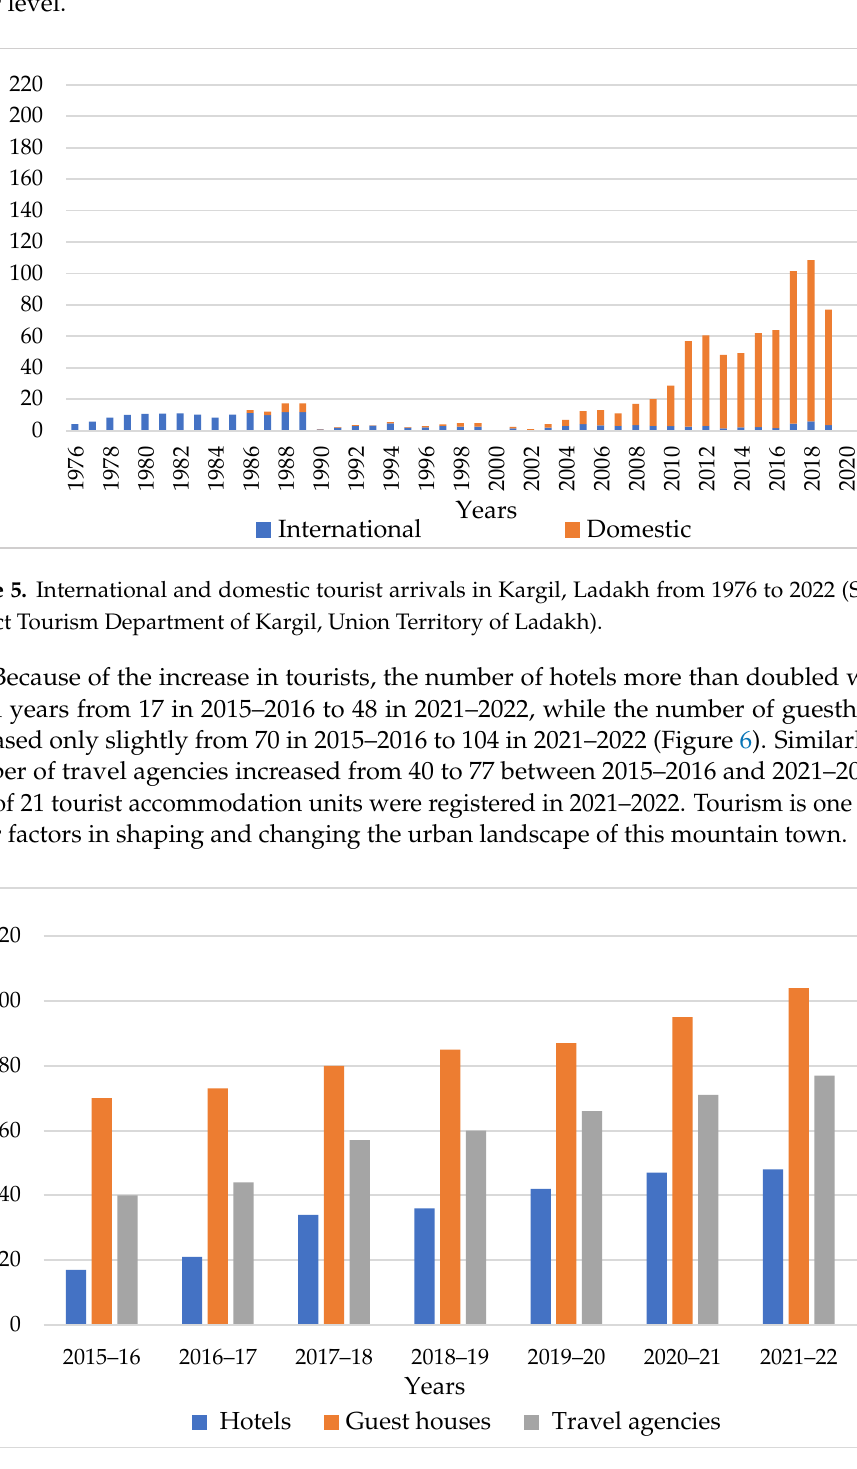
Figure 6. Total number of hotels, guest houses and travel agencies in Kargil, Ladakh (Source: District Tourism Department of Kargil, Union Territory of Ladakh).